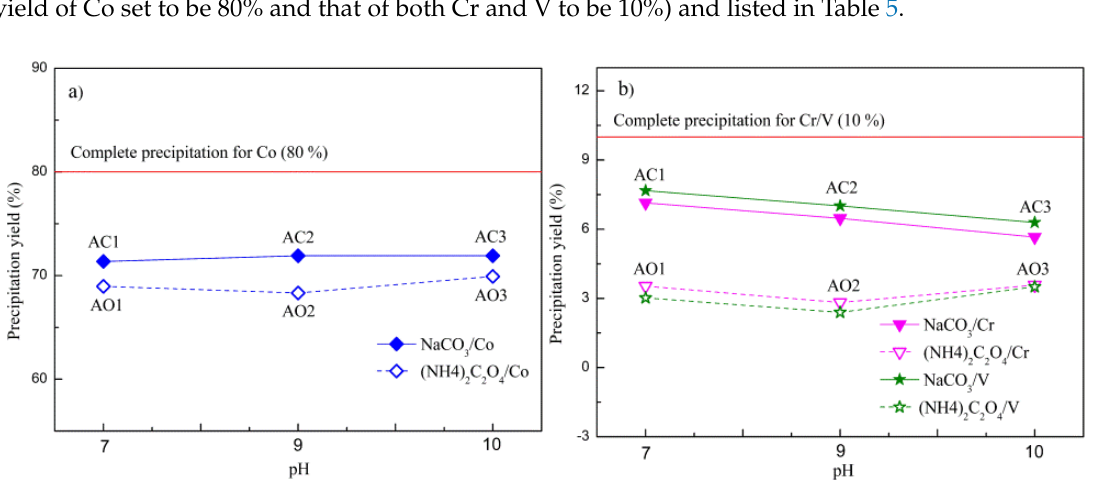
Figure 6. Yields of: ( a ) Co; and ( b ) Cr and V as functions of precipitant and pH. Table 5. Chemical compositions of precursors and Co-Cr-V alloy powders.